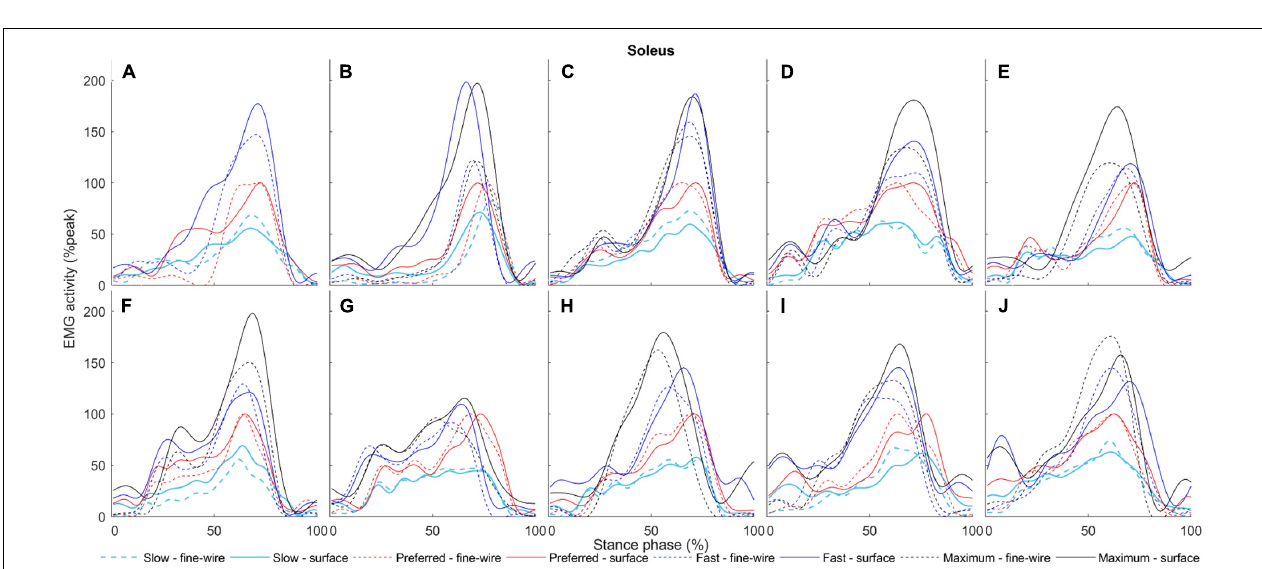
FIGURE 8 | Soleus surface (solid) and intramuscular (dashed) electromyography (EMG) activity at slow, preferred, fast, and maximum walking speeds (1.01 ± 0.13, 1.43 ± 0.19, 1.84 ± 0.23, and 2.20 ± 0.38 m s − 1 , respectively) in the stance phase for each individual ( A–J , respectively). The amplitudes of smoothed and time-normalised EMG curves were normalised to peak activity in preferred speed walking (%peak). Each curve represents the average of all steps at a given walking speed.